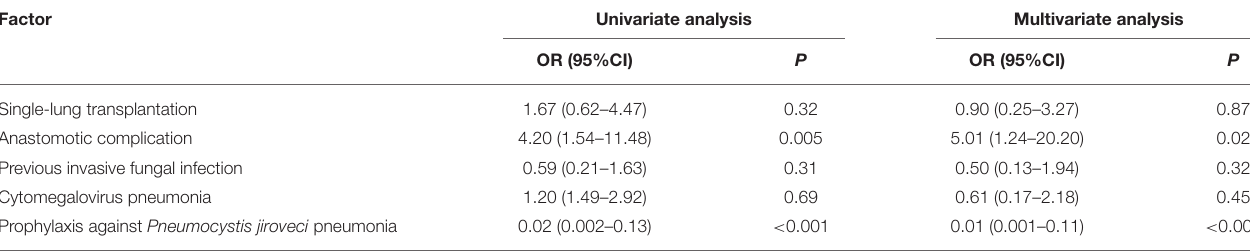
TABLE 3 | Logistic regression analyses of factors associated with mortality in patients with invasive fungal